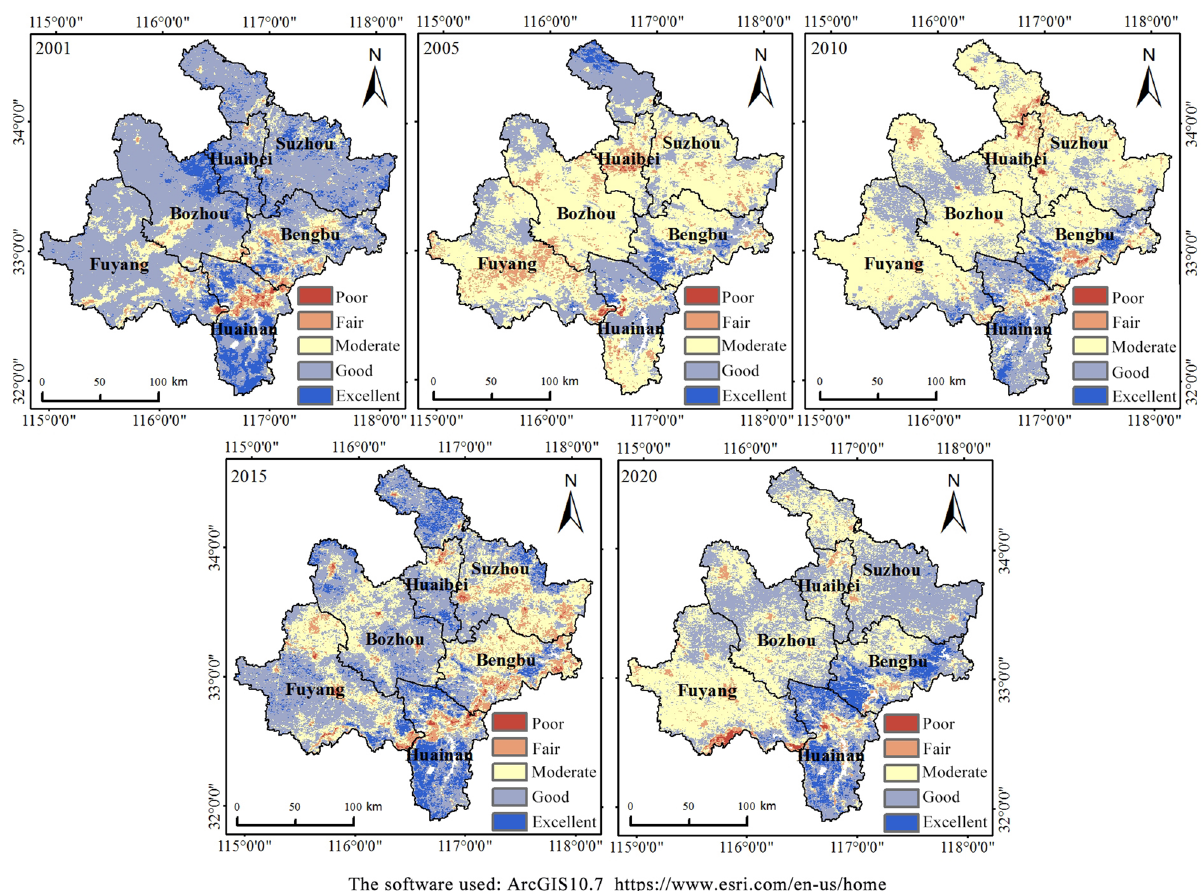
Figure 4. RSEI grade map of northern Anhui from 2001 to